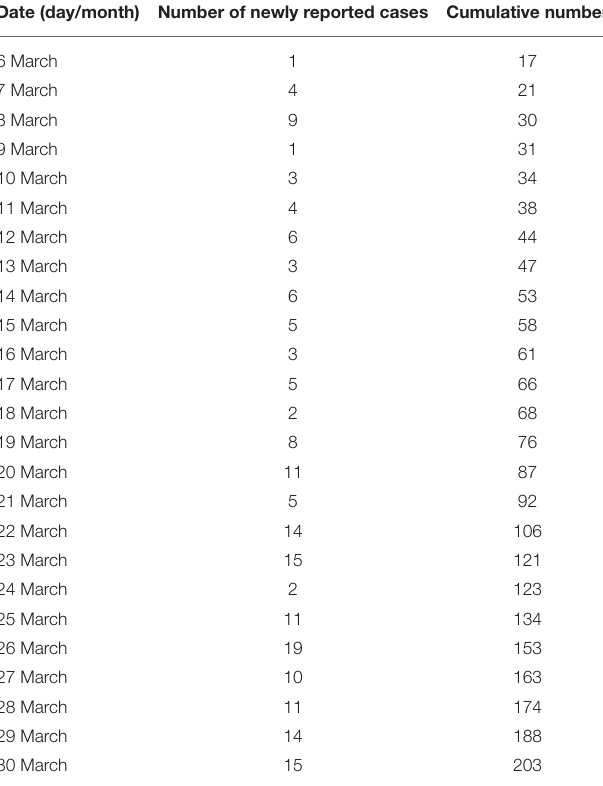
TABLE 2 | Number of daily and cumulative reported number of COVID-19 in Vietnam from March 31, 2020 to May 3, 2020 following the application of the lockdown.